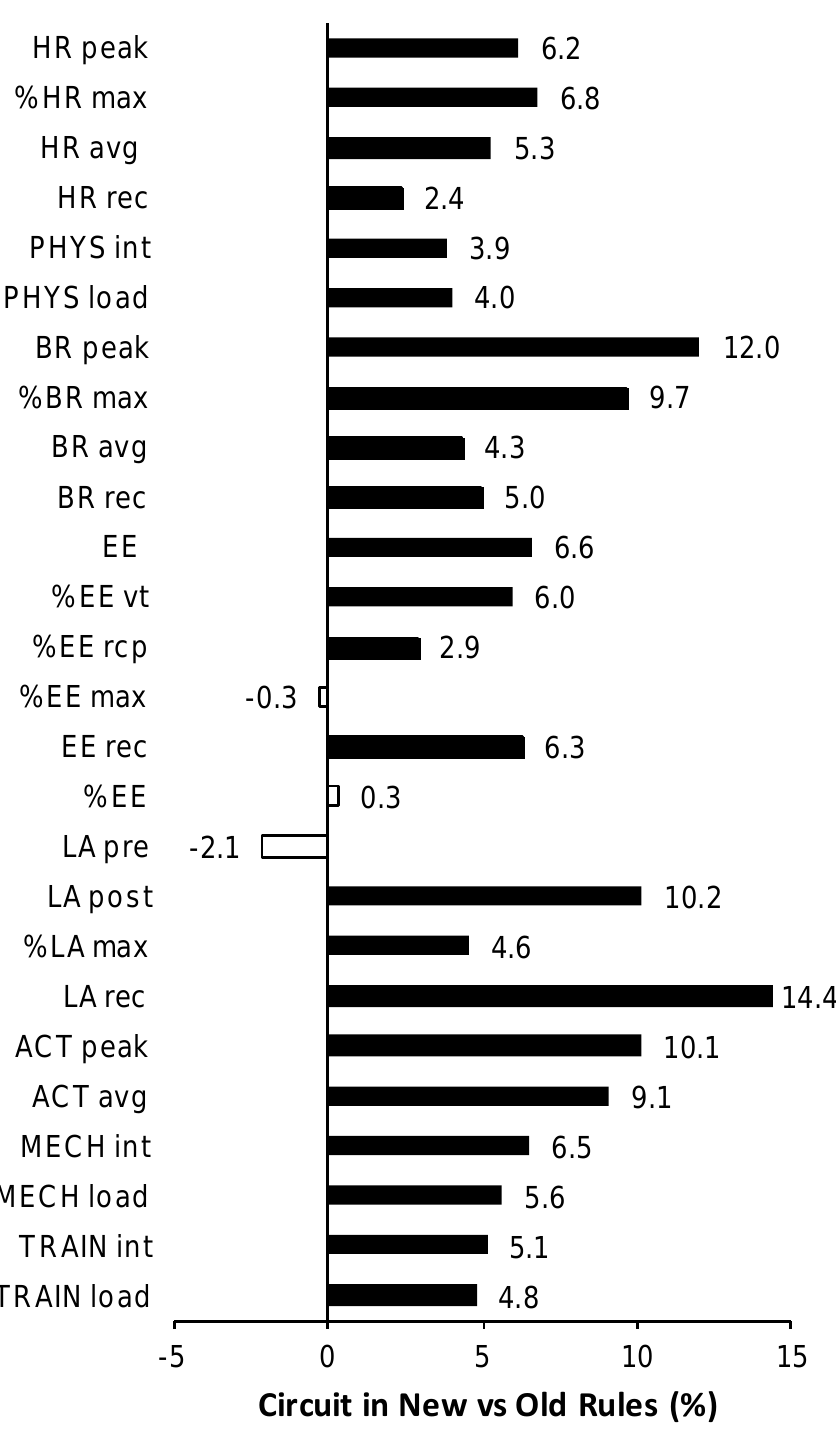
Figure 2. Percentage differences in exercise response to taekwondo-specific circuit workouts between new and old rule settings. Black bars denote statistically significant and white bars insignificant changes, as indicated in Tables 2–6. Positive numbers indicate higher values obtained in new vs. old rules. See table legends for the explanation of variable abbreviations.